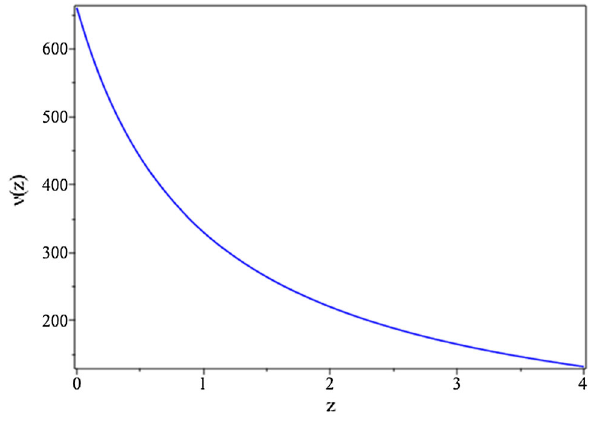
Fig. 1 The growth of the velocity contrast for Eq. (123) (GR limits)